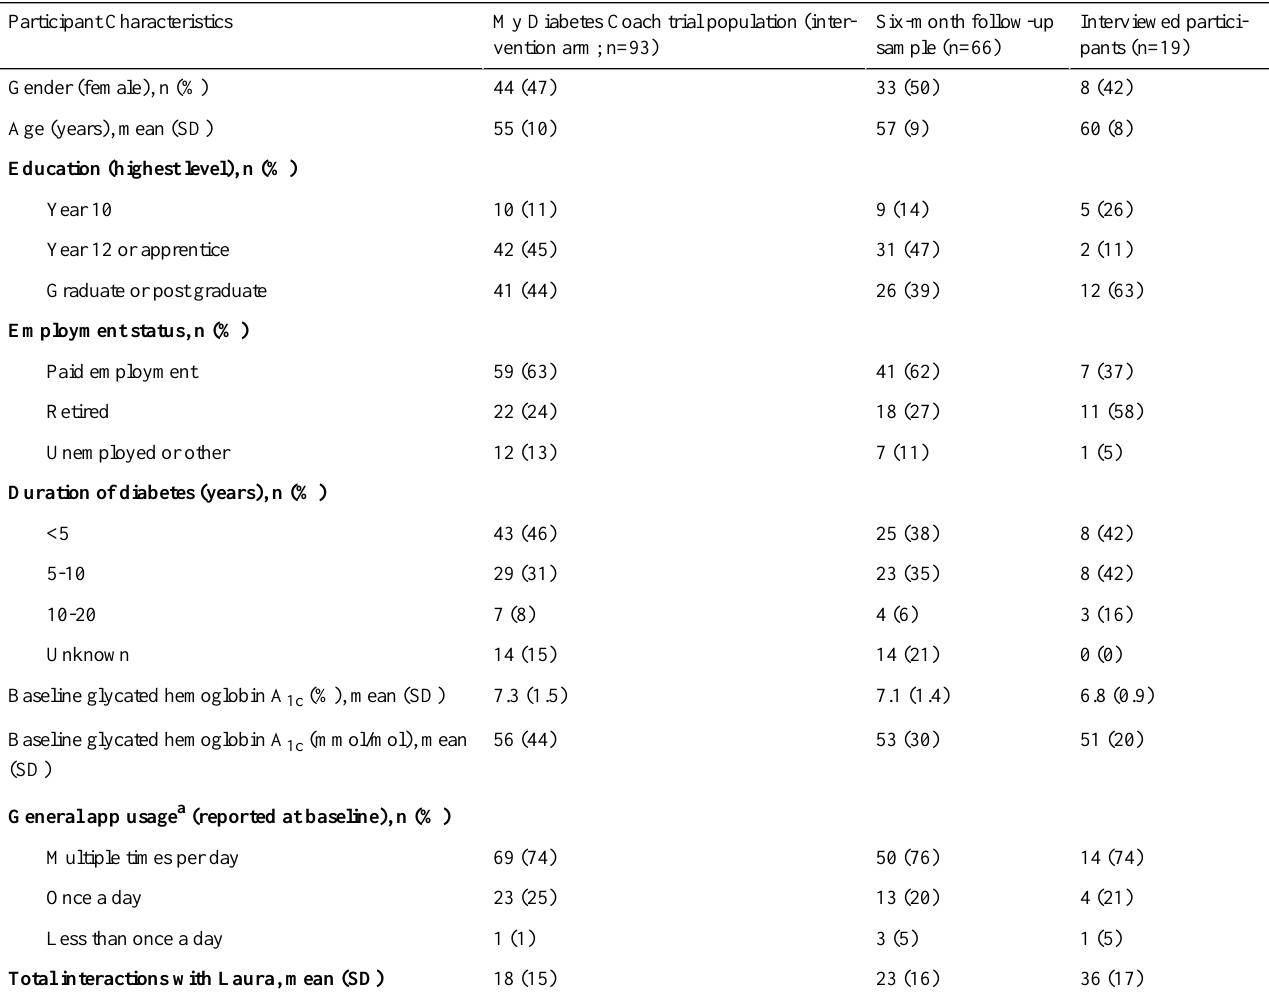
Table 1. Demographic and clinical characteristics of the total sample and interviewed